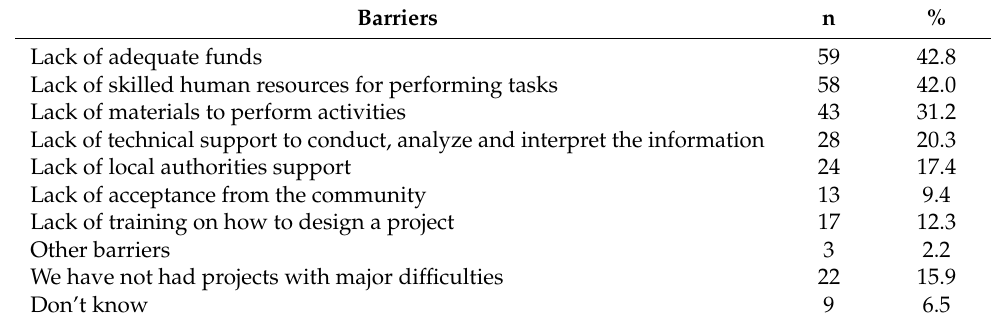
Table 3. Barriers for the implementation of local projects aimed to promote healthy habits from survey respondents (n =